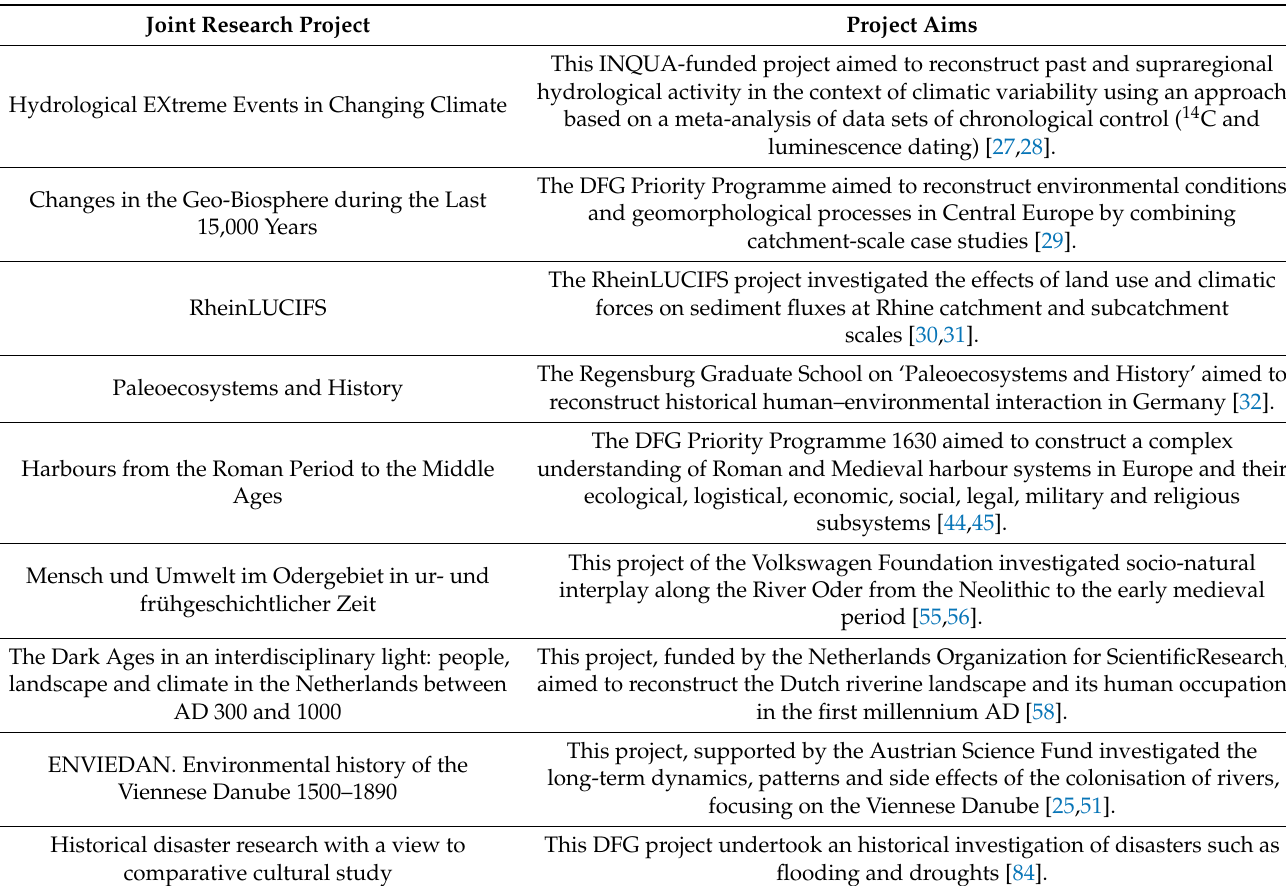
Figure 3. The Fluvial Anthroposphere as a socionatural site. Table 1. Joint research projects mentioned in the